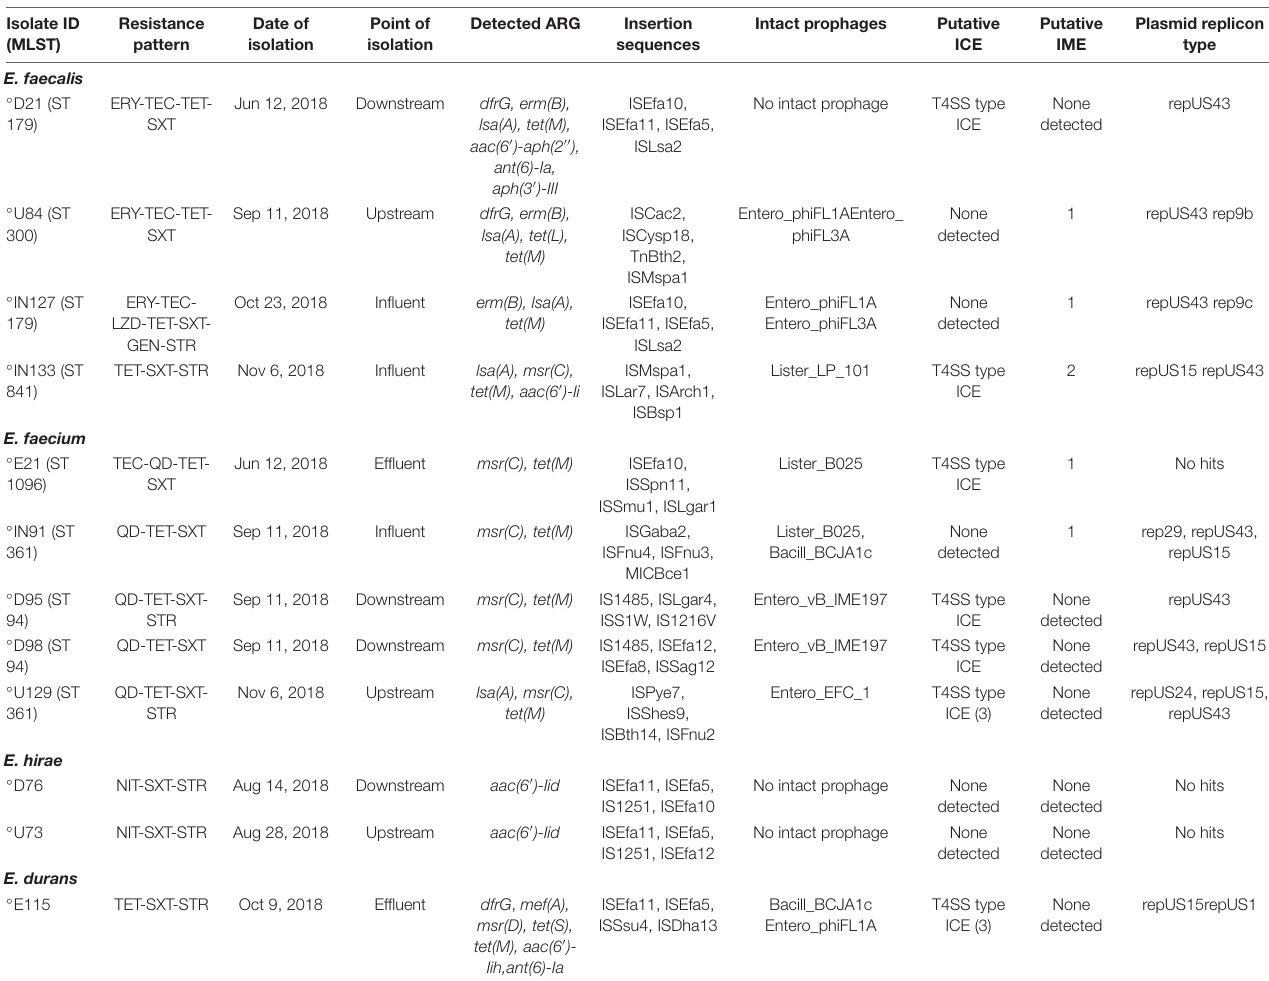
TABLE 1 | Distribution of antibiotic resistance genes and mobile genetic elements in environmental Enterococcus spp. Isolate ID